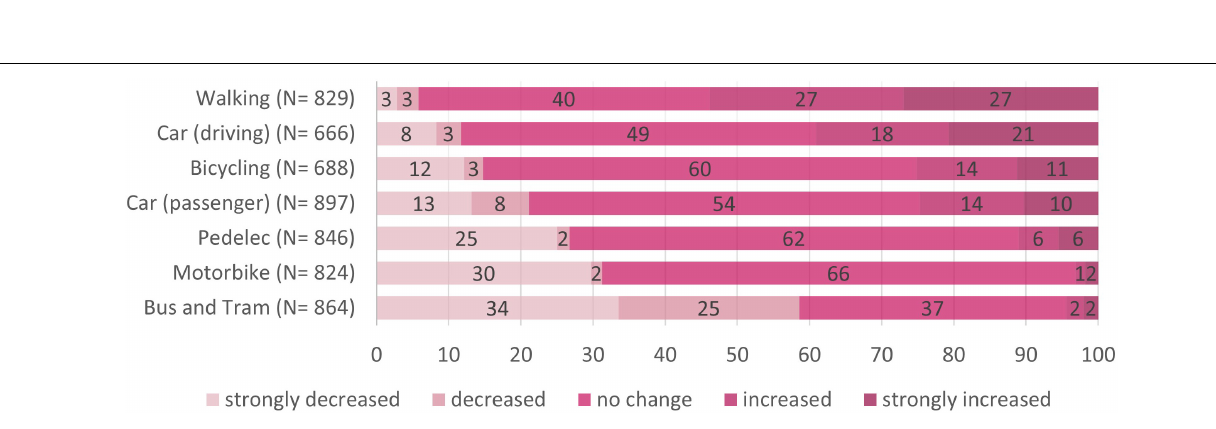
FIGURE 3 | Transport mode shift from before to during the COVID-19 pandemic. N = 918; numbers on the bars represent percentages.